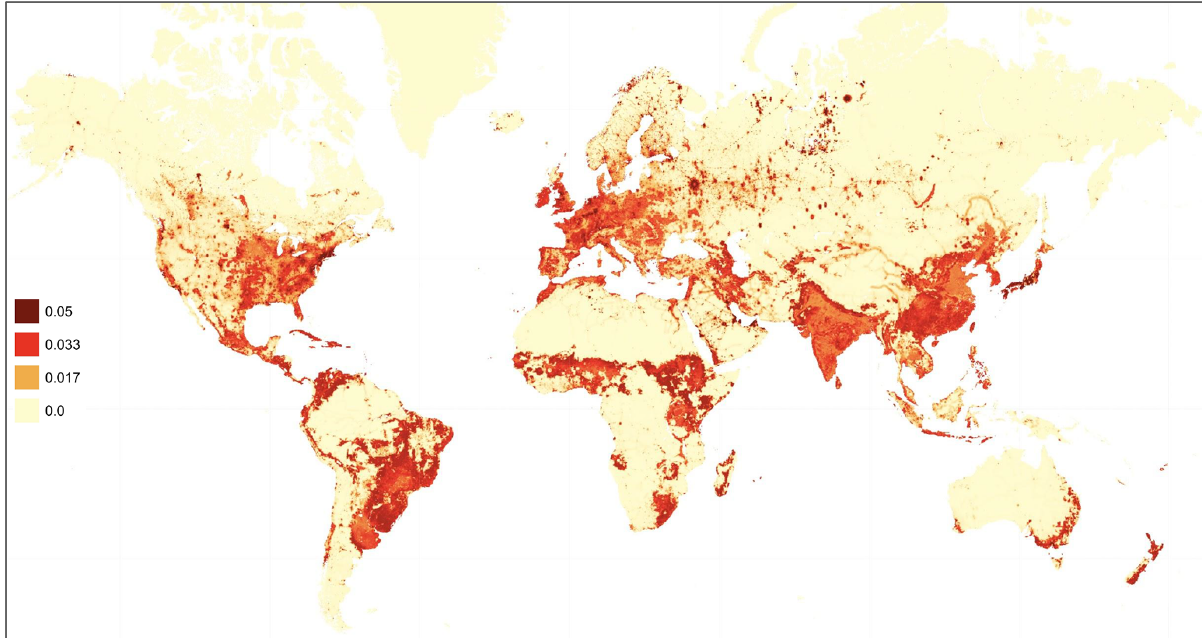
Figure 4. A map of the uncertainty as a result of randomizing the intensity factors when calculating the degree of human modification for 2017, showing the per-pixel standard deviation of 50 randomized maps. The highest levels of uncertainty tend to be in more highly developed landscapes (minimum = 0.0, median = 0.0, mean = 0.009, standard deviation = 0.014, maximum =